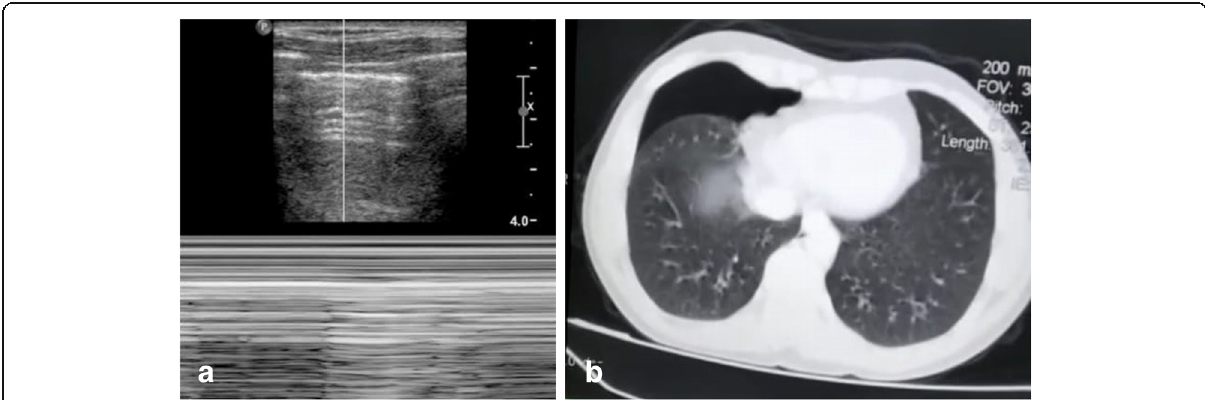
Fig. 1 Radiological imaging for the same trauma patient diagnosed with moderate pneumothorax on the right side: ( a ) E-FAST image shows the sea shore sign (lung sliding sign) at the view 4 on the right hemithorax; ( b ) CT chest (pulmonary window), moderate right-sided pneumothorax